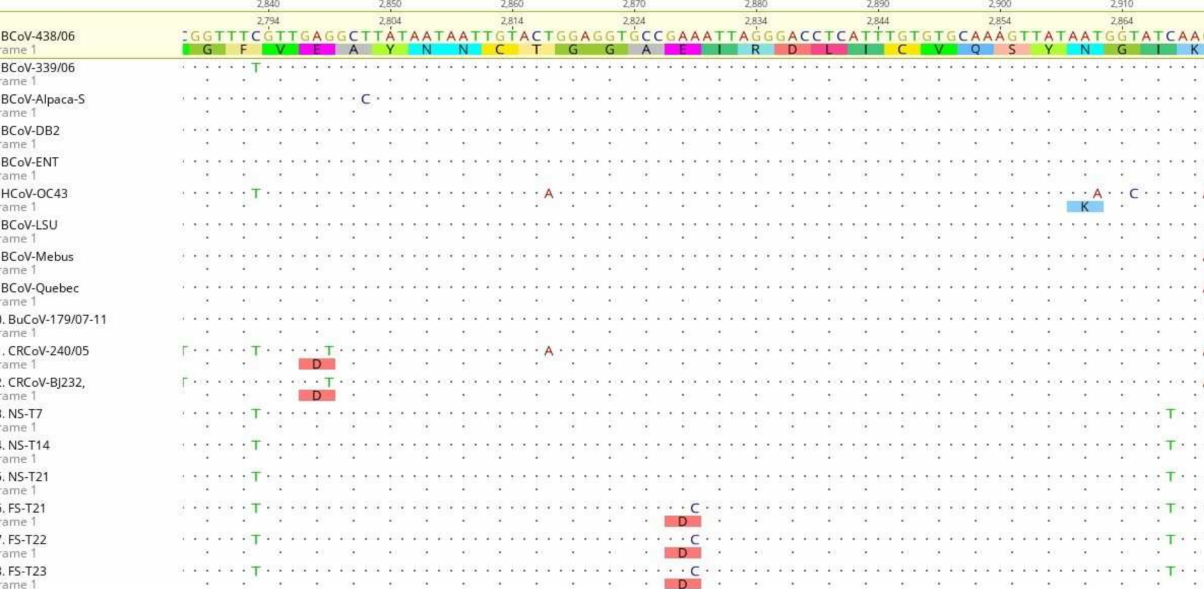
Figure 7. S gene sequence analysis. Alignment of partial nucleotide sequences and translated amino acid sequences in the spike protein of 18 Betacoronavirus strains: 12 reference strains (seq 1 to 12) (GenBank accession numbers EU14648.1, EF445634.1, DQ915164.2, DQ811784.2, AF391541.1, KX344031.1, AF058943.1, U00735.2, AF220295, EU19216.1,